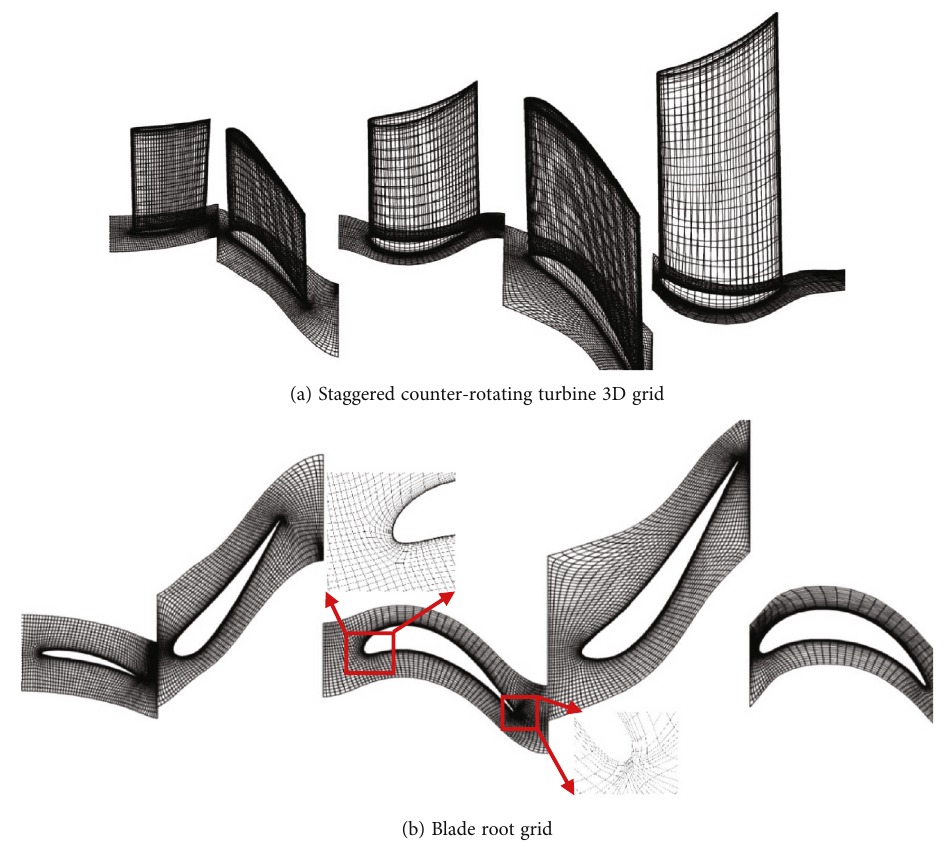
Figure 8: Staggered counter rotating turbine blade